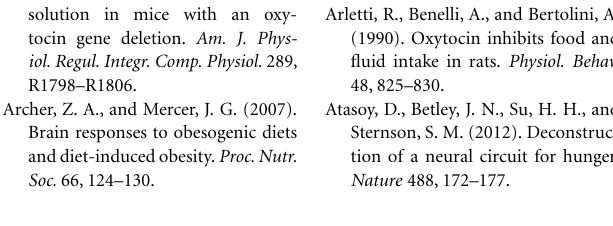
oxytocin release. (E) Application of α -MSH retrodialysis to the SON affects the electrical activity ofVMN neurons in vivo . Mean change in firing rate ( ± SE) inVMN neurons that were not affected (open bars; n = 13), and activated (solid bars; n = 8; P < 0.005, 0–30min vs. control) in the 30min period from the start of α -MSH infusion (100 µ M) on the